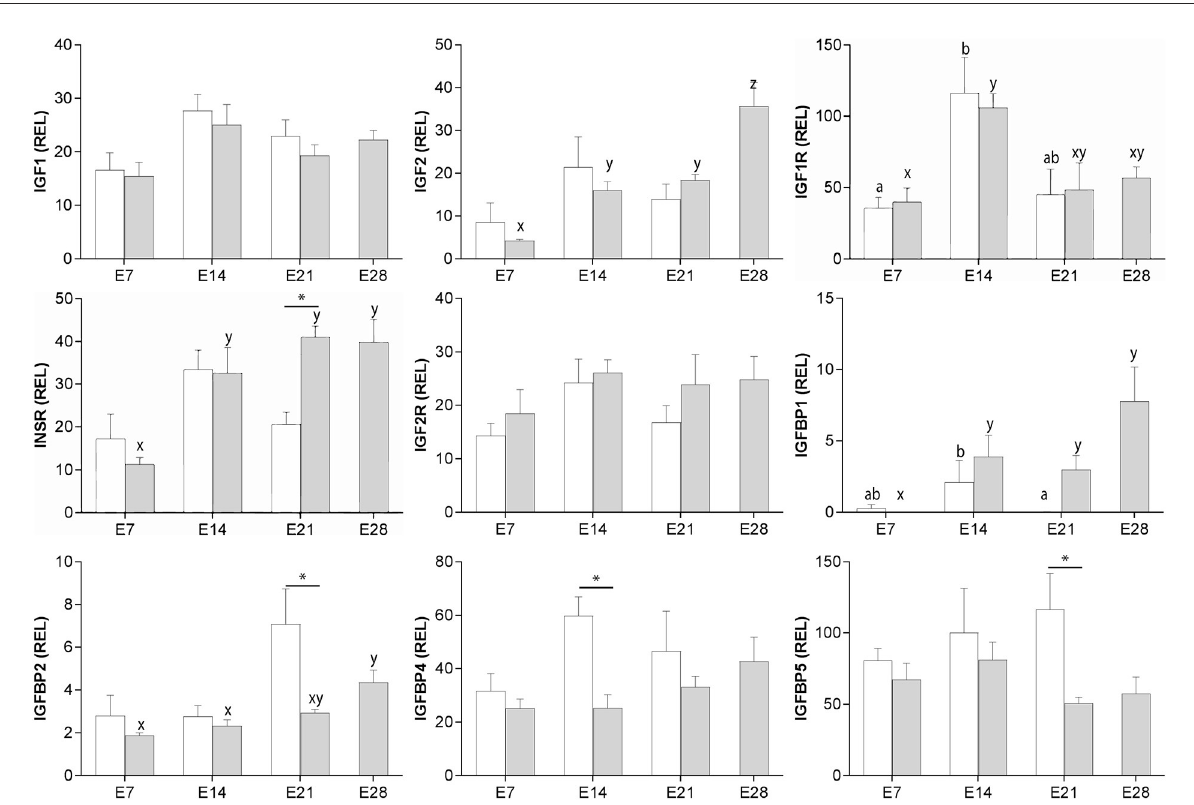
FIGURE1 Relative gene expression (mean ± s.e.m) for IGF1 , IGF2 , IGF1R , INSR , IGF2R , IGFBP1 , IGFBP2 , IGFBP4 and IGFBP5 in equine endometrium from cyclic (white bars) or pregnant mares (gray bars) on days 7, 14, 21 and 28 (pregnancy only) after ovulation. Values are calculated as the ratio